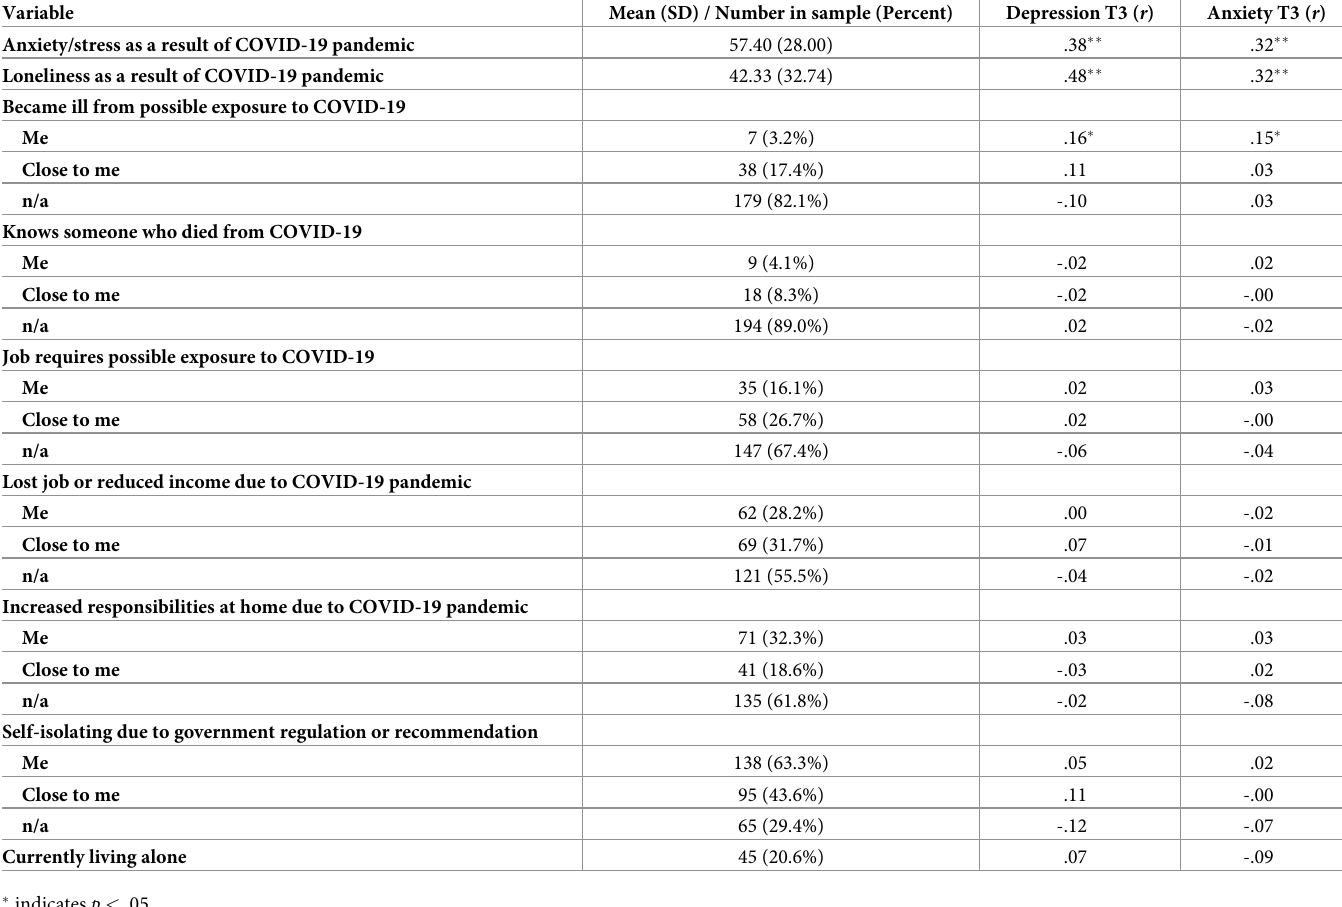
common stressors (e.g., “Job requires possible exposure to coronavirus”; See Table 1 for list of Table 1. Stressors related to COVID-19 and cross-sectional correlation with depression and anxiety. Variable Anxiety/stress as a result of COVID-19